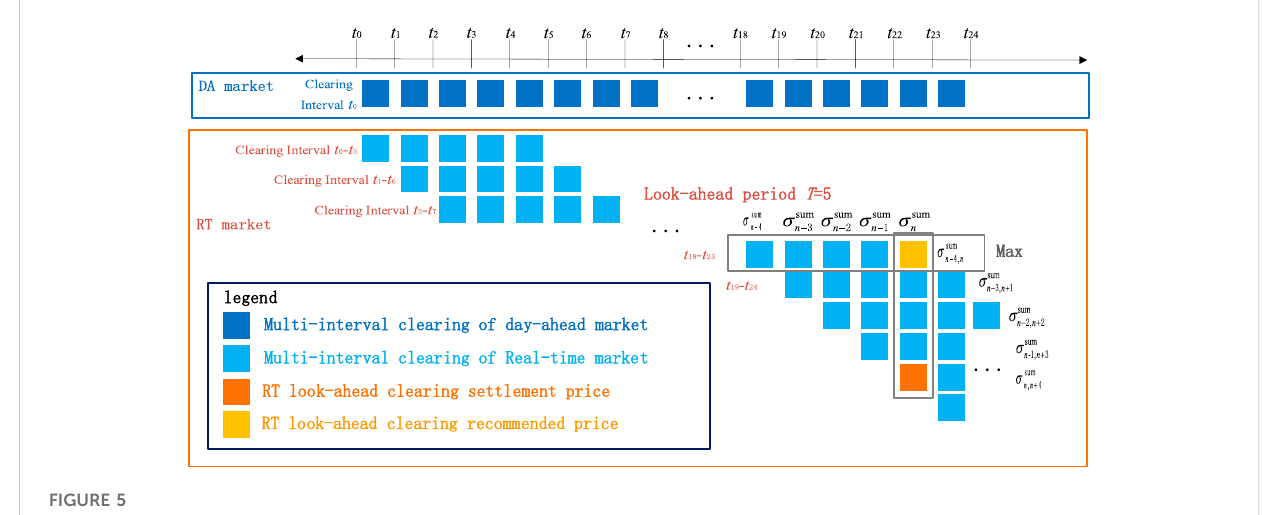
FIGURE 5 New settlement